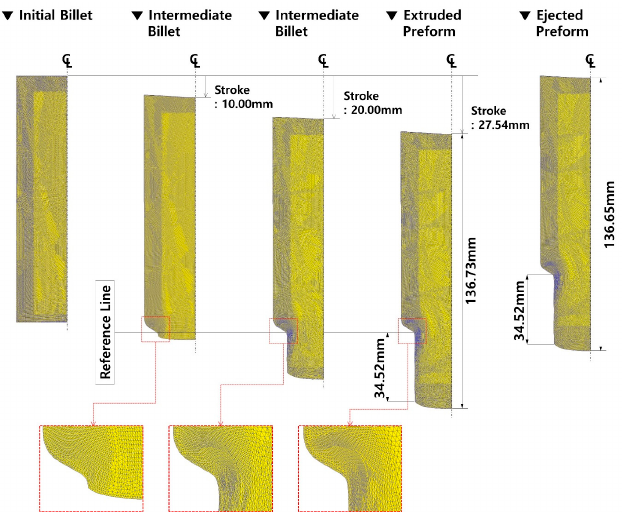
Figure 8. Deformation history during forward extrusion and ejection in the case where plastic ma- terial model was applied. material model was